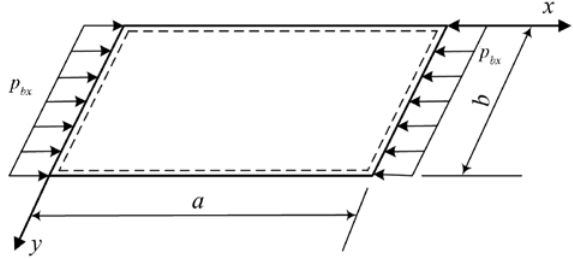
Figure 2: Plane geometric sketch of delaminated plate under uniaxial